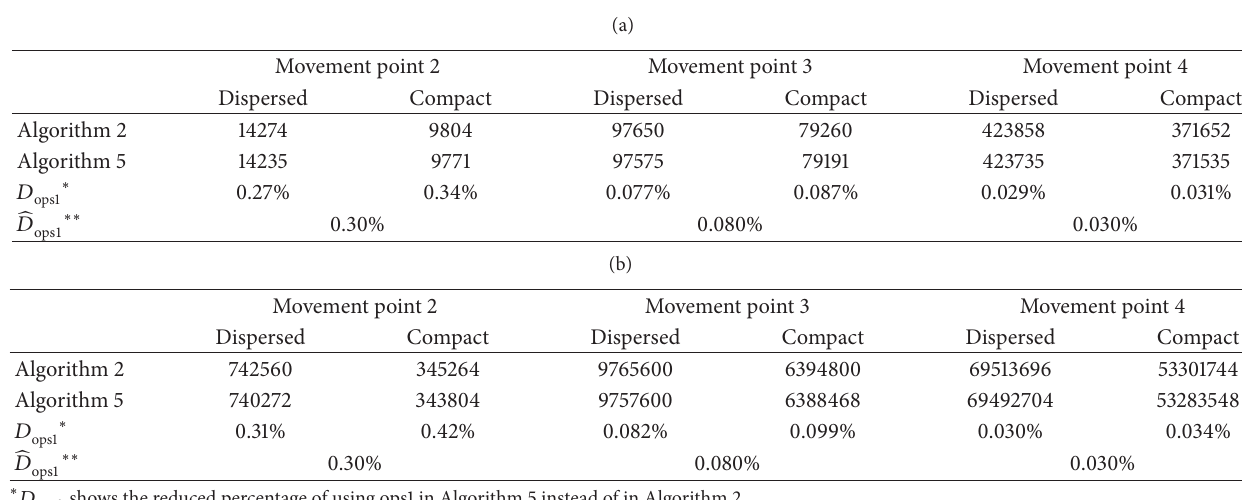
Table 2: (a) For three units, the comparison of ops1 under different movement points and different dispersions. (b) For four units, the comparison of ops1 under different movement points and different dispersions.